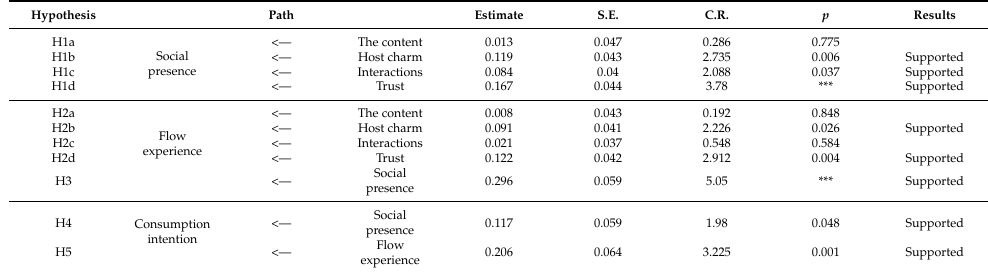
Table 4. Coefficients of latent variable paths.